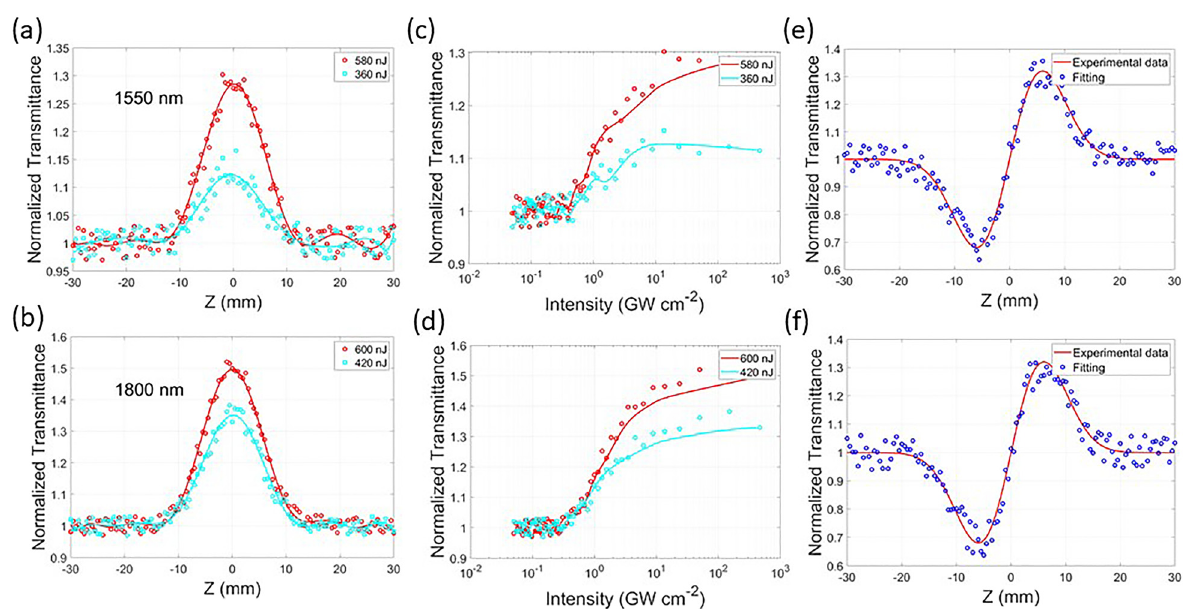
Figure 2: Characterization of the NLO properties of the GDY film. (a) and (b) The OA Z-scan tests of the GDY fi lm at 1550 and 1800 nm, respectively. (c) and (d) Normalized transmittance versus the intensities at 1550 and 1800 nm, respectively. (e) and (f) The CA Z-scan tests of the GDY fi lm at 1550 and 1800 nm, respectively.